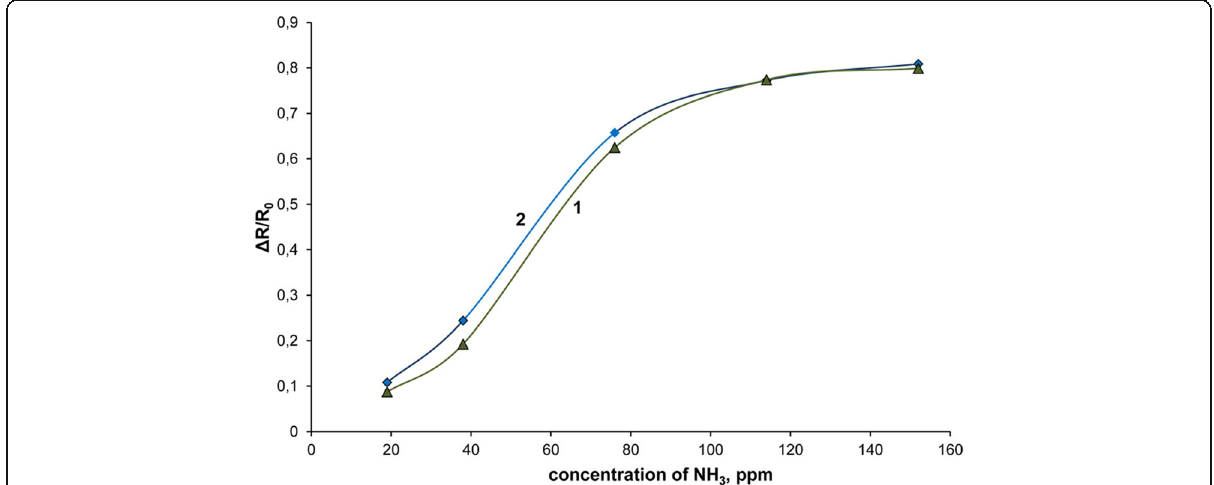
Fig. 6 Sensor responses (calibration curves) of the cast pure PANI-LSA ( 1 ) and NC15 ( 2 ) films to different concentrations of ammonia in the mixtures with